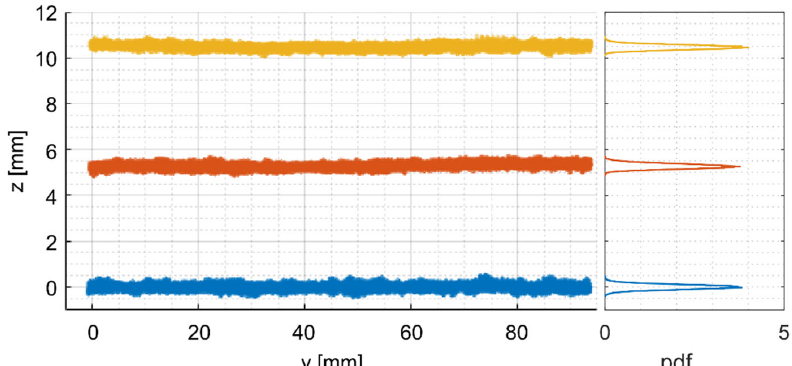
Figure 5. Measurement of the diffuse reference surface in the glove box at different height levels. The measured averages are 0 mm, 5.3 mm and 10.5 mm. The standard deviation is 0.11 mm. On the right, the probability density function (pdf) is shown.